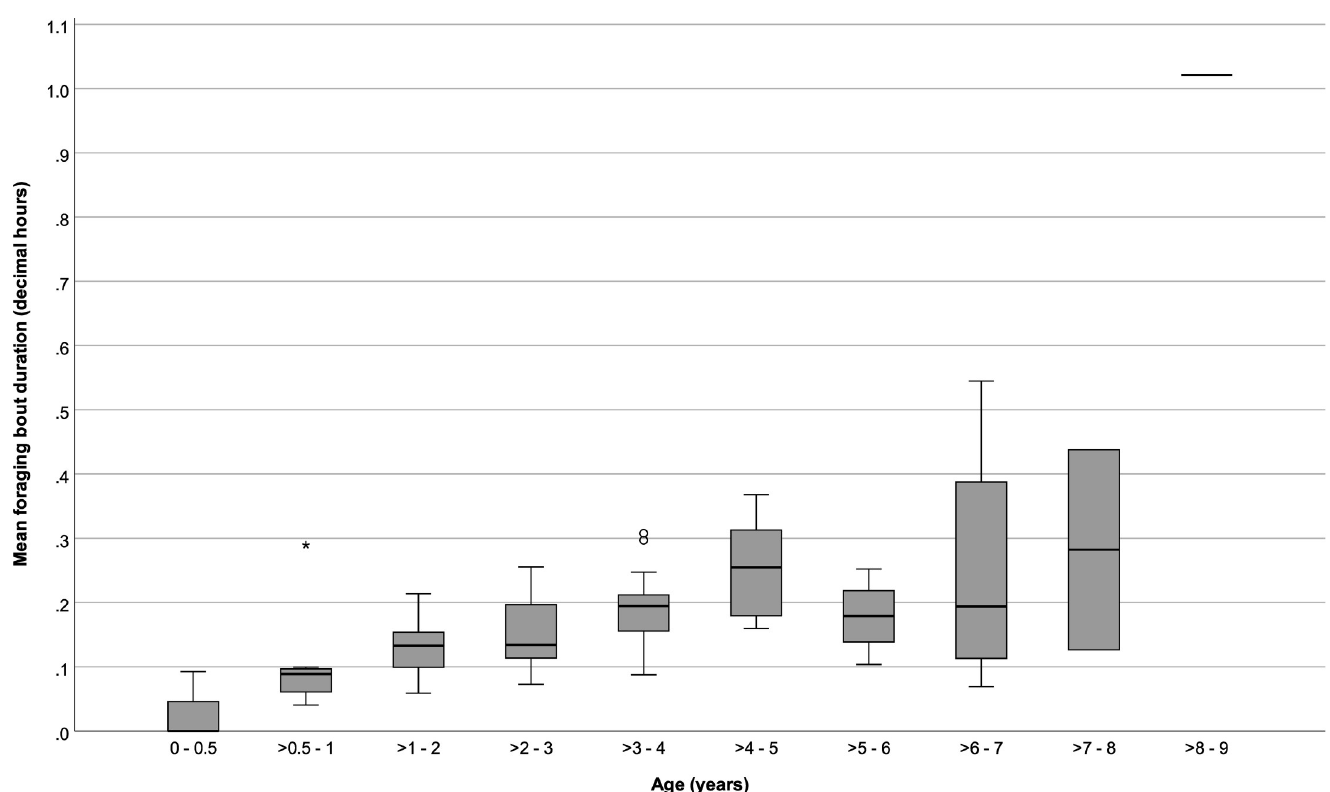
Fig 6. Average foraging bout durations of immature chimpanzees at different ages. Box plots show median values (solid horizontal lines), 25th and 75th percentile values (box boundaries), highest and lowest values (whiskers), outliers (circles), and extremes (asterisks).